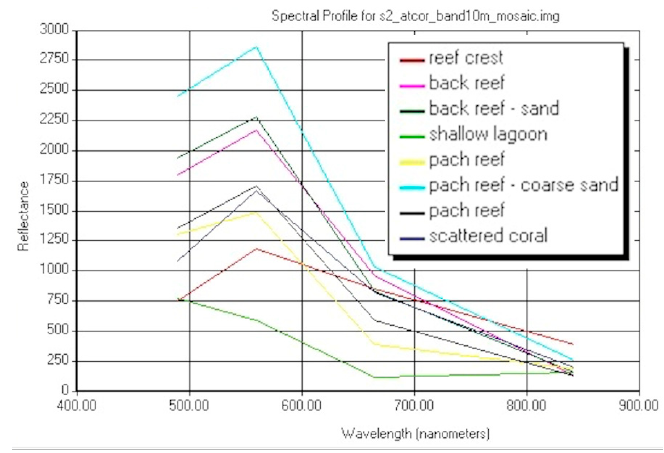
Figure 7. Spectral signatures of reef coverage (the barrier reef zone, site no. 1) in ERDAS software.